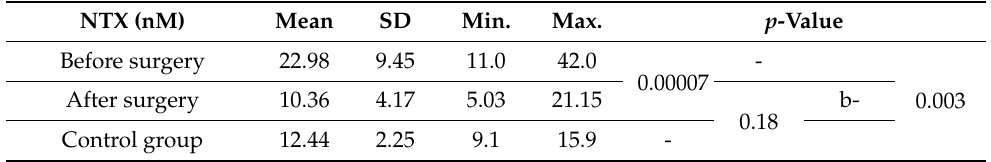
Table 5. Serum concentrations of NTX (N-terminal telopeptide of type I collagen) in study group vs. control group.